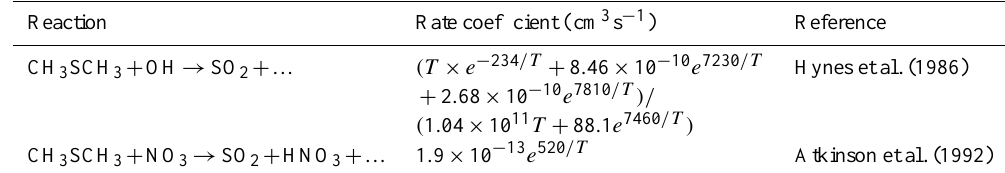
Table. C5. DMS oxidation reactions. T is the temperature in